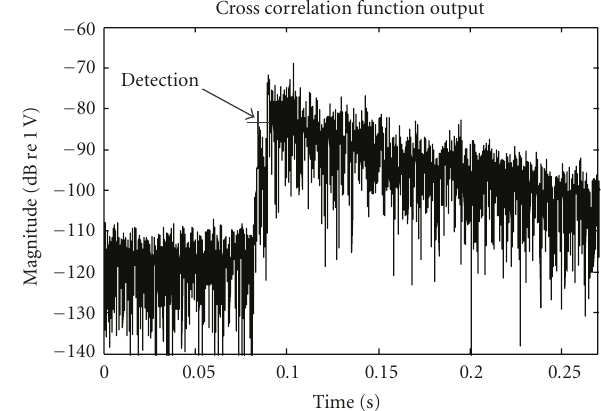
Figure 8: The actual positions of the nodes as surveyed by the carrier-phase tracking. GPS with regard to a local reference point. The contours depict the varying height of the site.